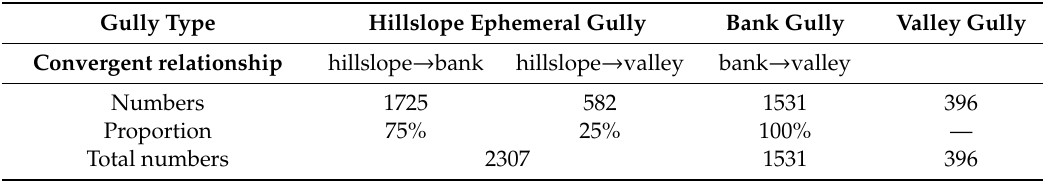
Table 4. Convergent relationship of three types of gullies.